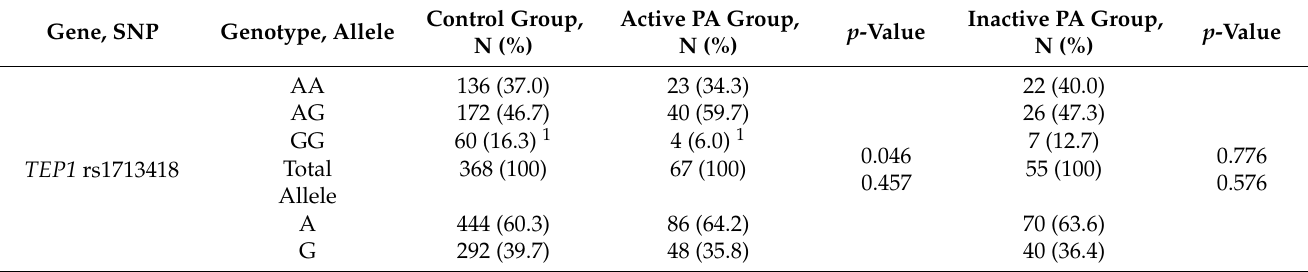
Table 4. TEP1 and TERC genes single nucleotide polymorphisms Frequencies of genotypes and alleles within active or inactive pituitary adenoma and control